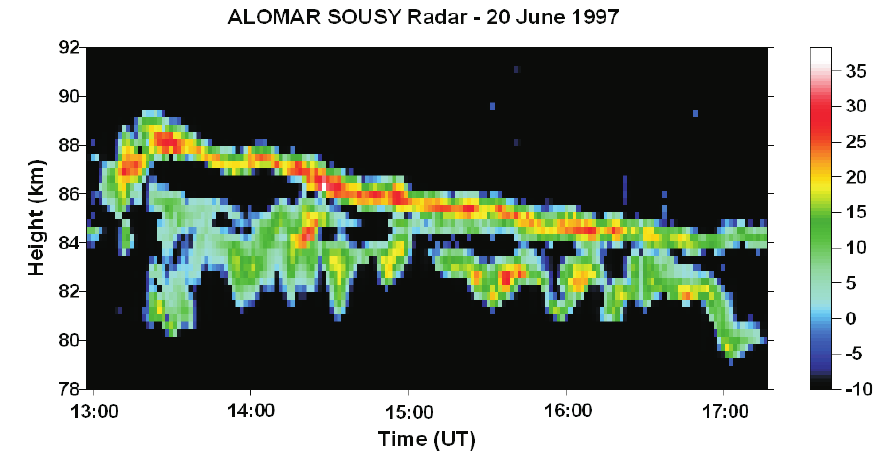
Fig. 9. Example of a short period variation of the lower edge of an observed PMSE.